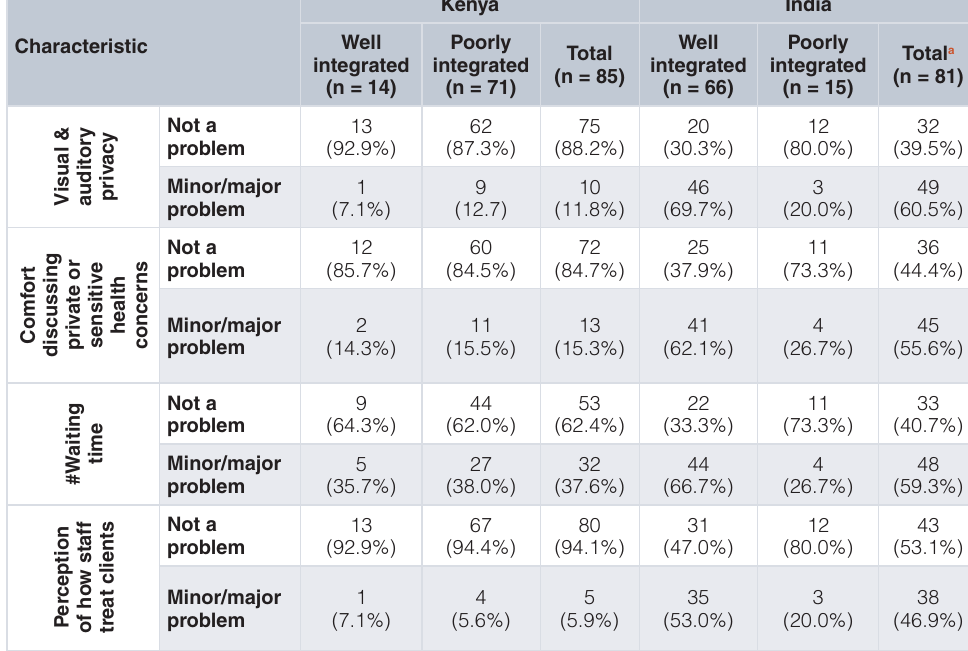
Table 3. Antenatal care clients report on privacy, interactions with staff, and waiting time.